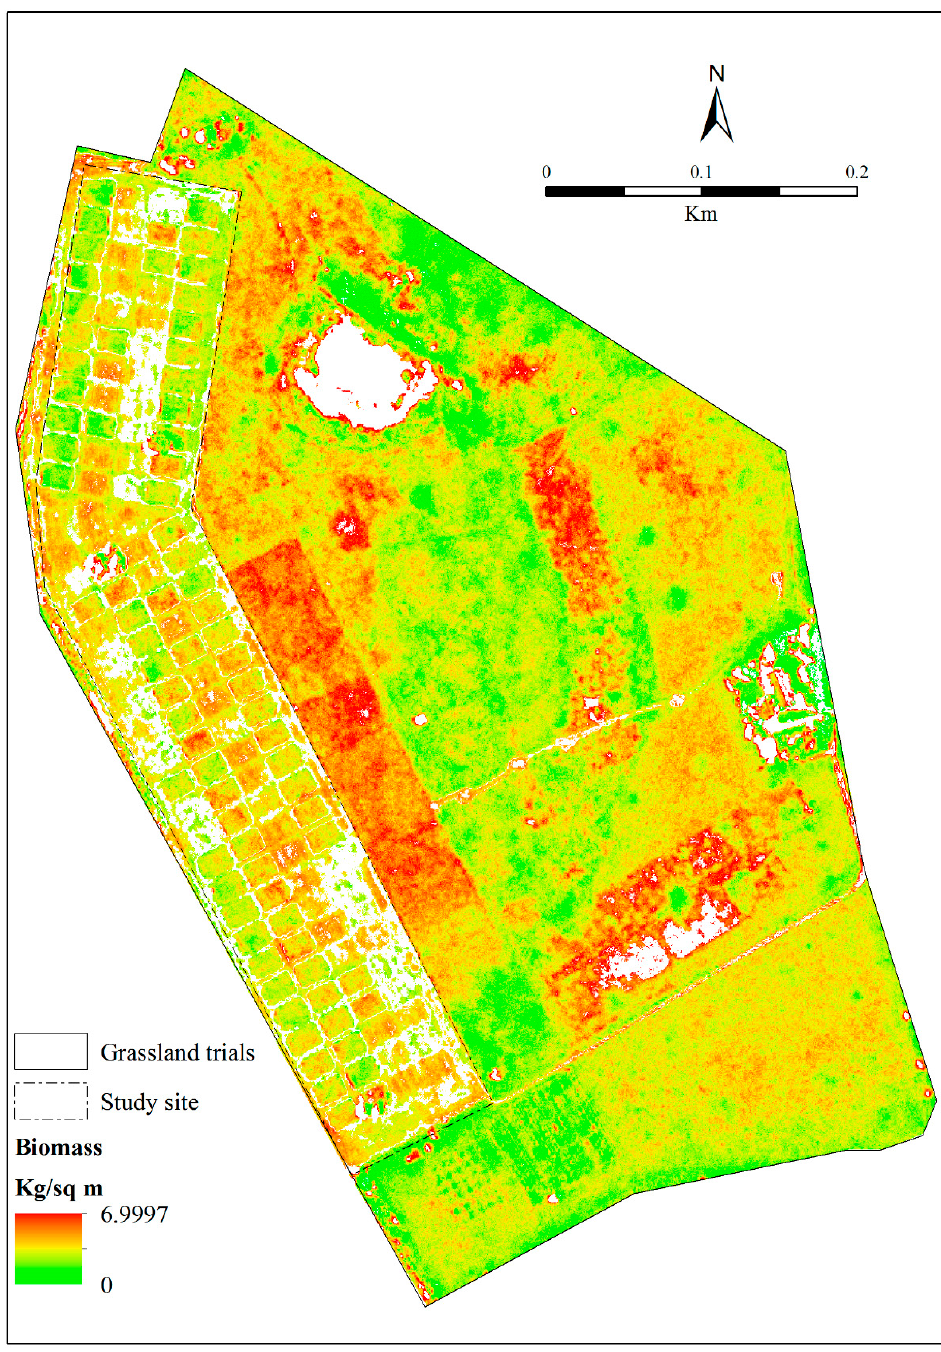
Figure 7. Spatial distribution of biomass across different grassland management